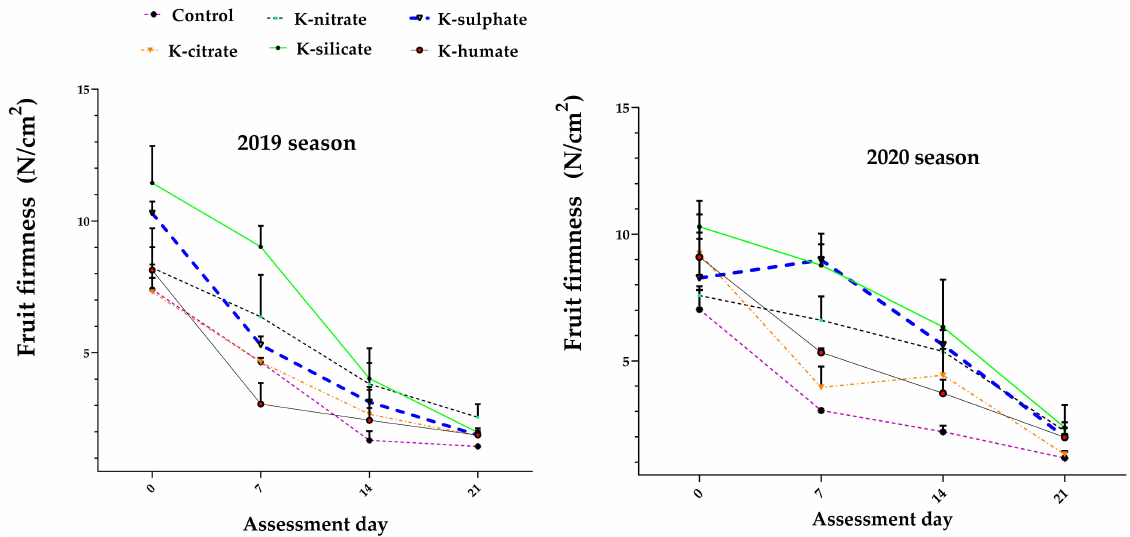
Figure 5. Effect of diverse potassium forms as foliar application on firmness of apricot fruits cv. ‘Canino’ in 2019 and 2020 seasons during cold storage 0 ± 1 ◦ C and 90 ± 5% RH. Values represent the mean with